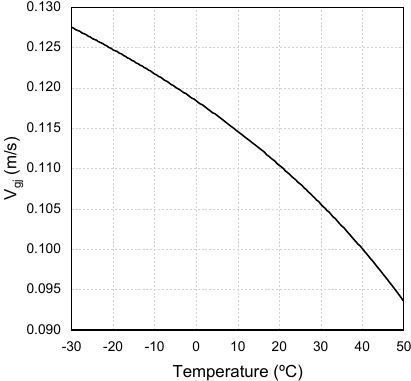
Figure 13. Drift velocity in function of the saturation temperature for R134a.